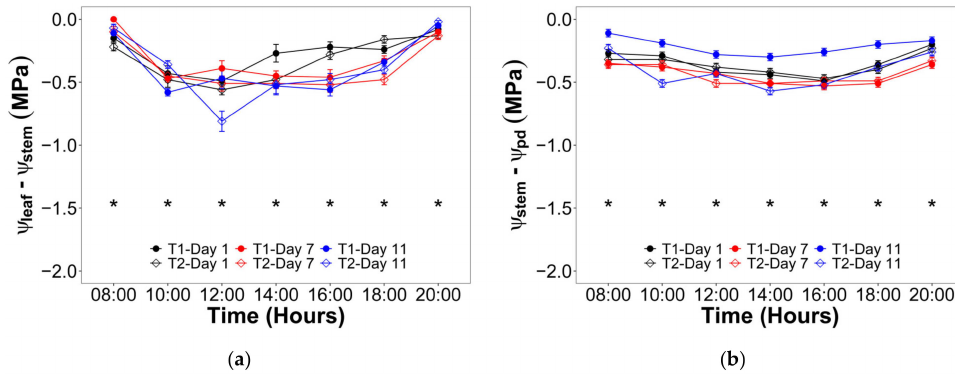
Figure 5. Hourly evolution of the water potential differential during the three evaluated days in the flowering stage between: ( a ) Leaf and stem ( ψ leaf − ψ stem ); ( b ) Stem and root represented by the predawn water potential ( ψ stem − ψ pd ). Significant differences between irrigation treatments in the three evaluated days for every hour are indicated by an asterisk.